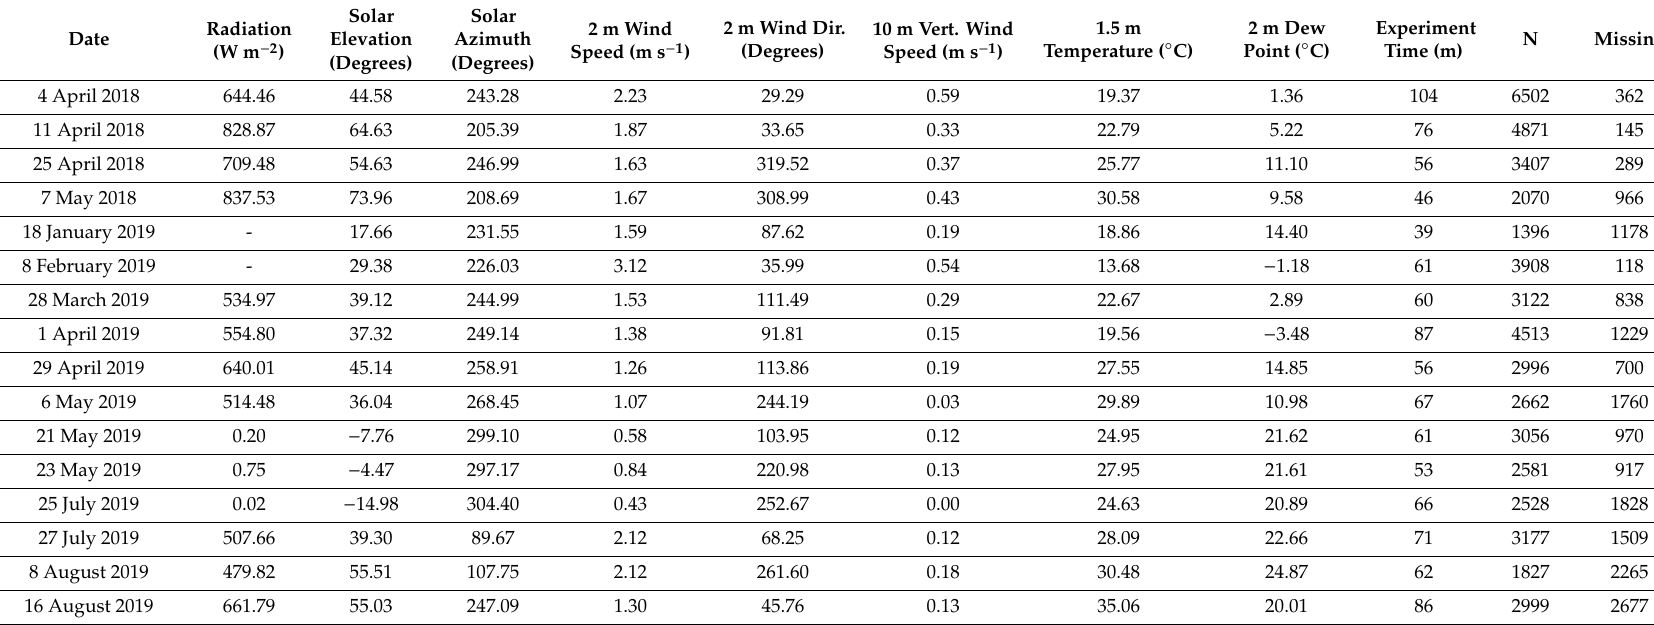
Table 1. Tower experiments by date with solar conditions, meteorological conditions, and experiment time averaged over the length of the experiment. Experiment duration, sample size (N), and missing values are also